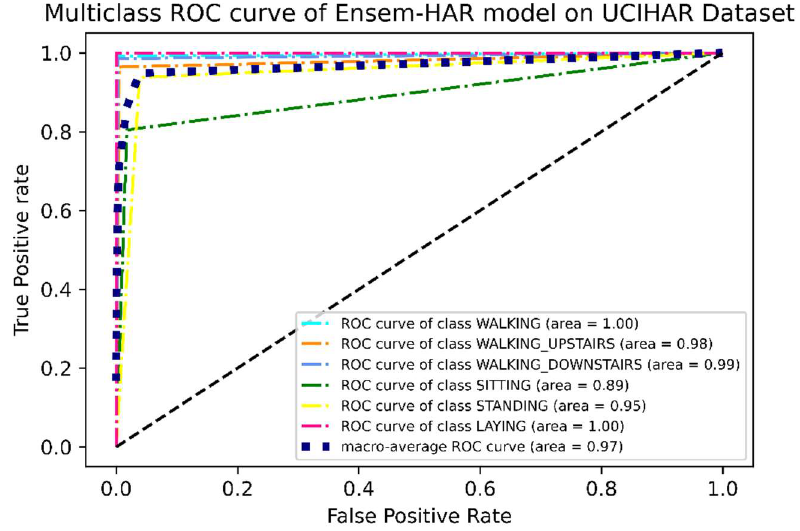
Figure 21. ROC curve (one vs. rest) of the proposed Ensem-HAR model on UCI-HAR dataset.